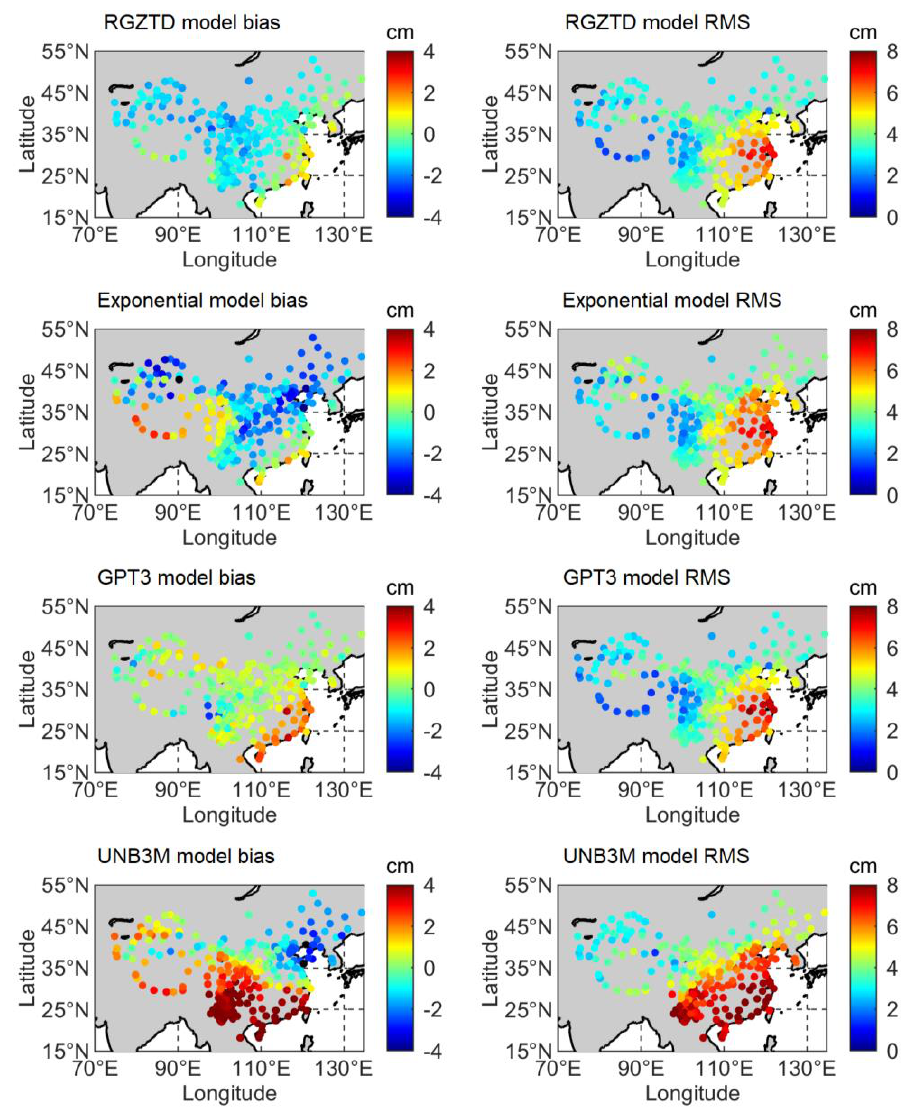
Figure 7. Distribution of bias and RMS of RGZTD model, Exponential model, GPT3 model and UNB3M model in China, where the CMONOC ZTD data is the reference value.